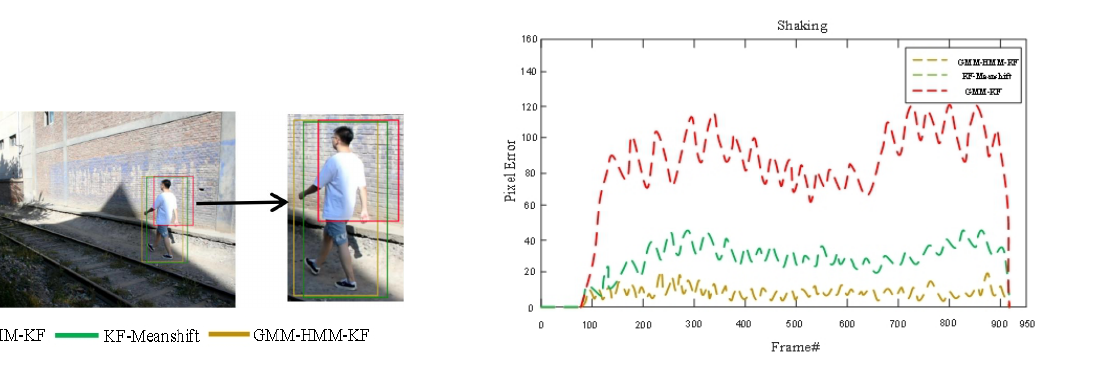
Fig. 14. The results after using three algorithms